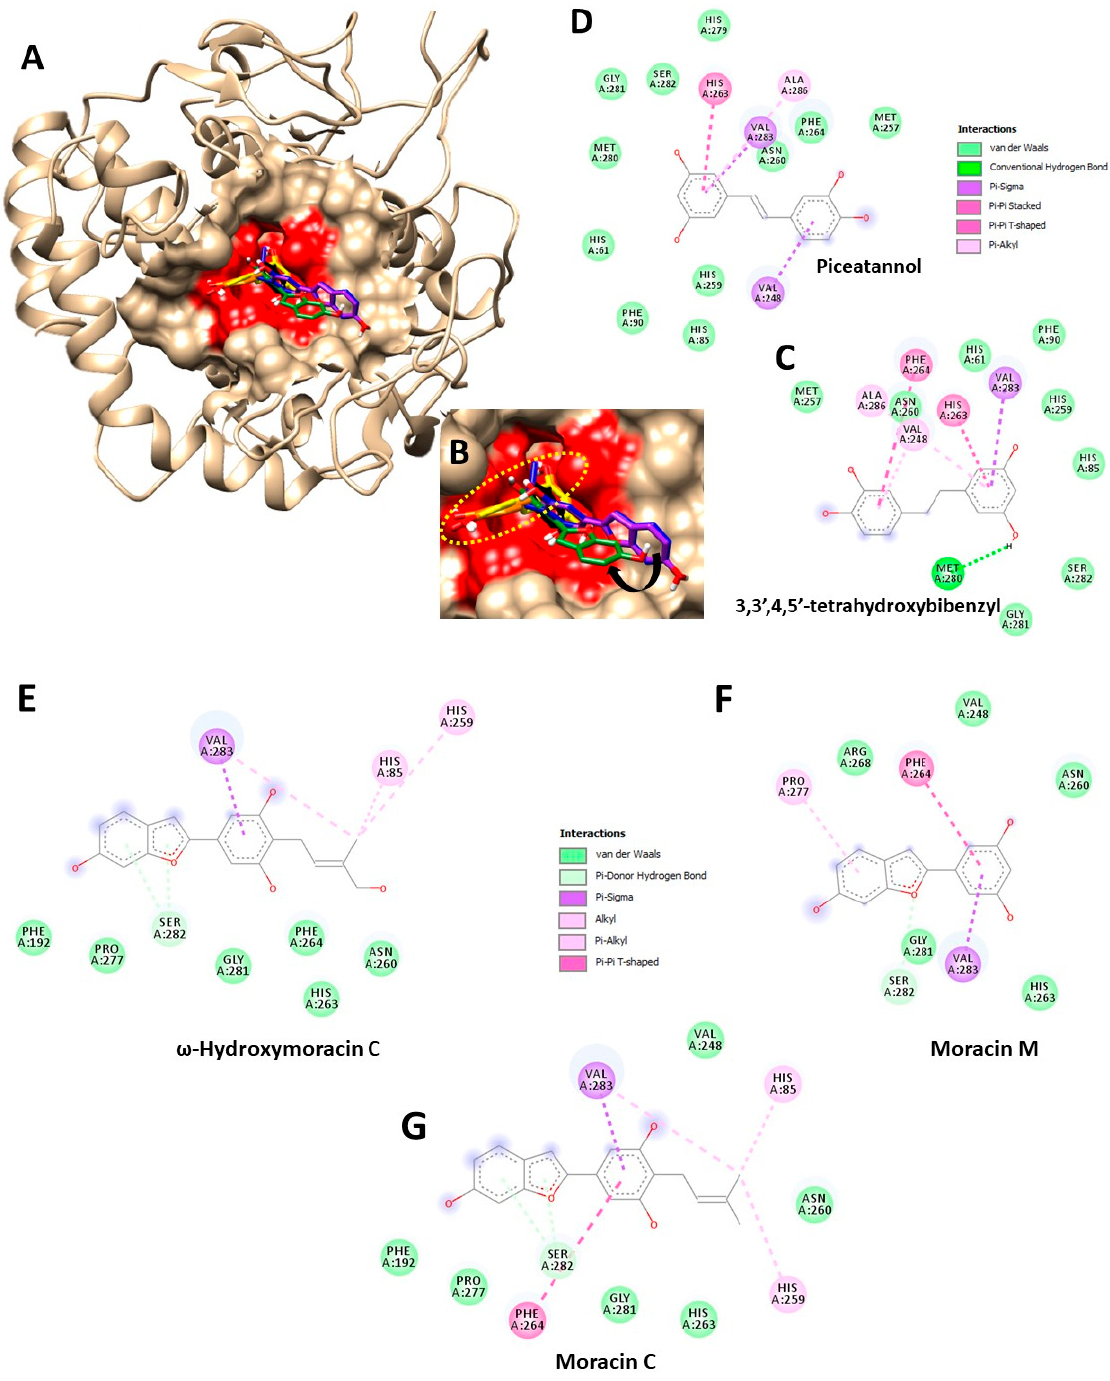
Figure 6. Theoretical binding mode of the isolated bioactive metabolites obtained from S. taxoides simulated by molecular docking. The blue ligand represents ω -hydroxymoracin C, Compound 1 , while the green indicates moracin M, Compound 2 , in the active site on mushroom tyrosinase. Additionally, the purple ligand is moracin C, Compound 3 . On the other hand, the orange ligand indicates 3,3 (cid:48) ,4,5 (cid:48) -tetrahydroxybibenzyl, Compound 4 , and the yellow ligand represents piceatannol, Compound 5 . ( A ) demonstrates an overall view of ligand-tyrosinase interaction, while ( B ) exhibits a close-up view of an active site of tyrosinase colored in red color. ( C , D ) reveal intermolecular interactions of 3,3 (cid:48) ,4,5 (cid:48) -tetrahydroxybibenzyl, piceatannol and catalytic amino acid residues on the mushroom tyrosinase. Finally, ( E – G ) exhibit intermolecular interactions between ω -hydroxymoracin C, moracin M, moracin C and tyrosinase’s catalytic amino acid